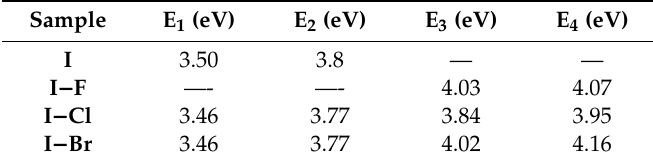
Table 5. Experimental electronic transitions (E g ) of I , I − F , I − Cl , and I − Br crystals.